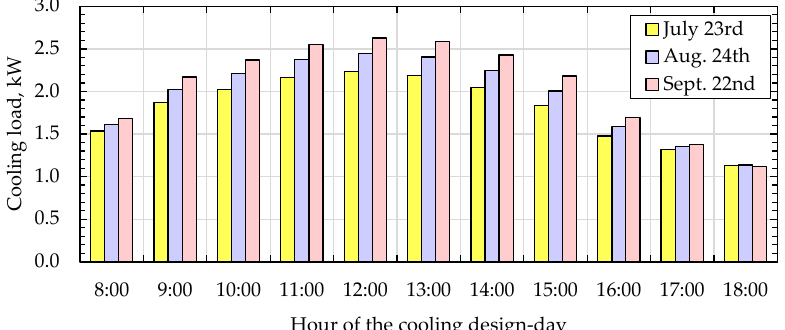
Figure 7. Hourly cooling loads for the selected design-days.